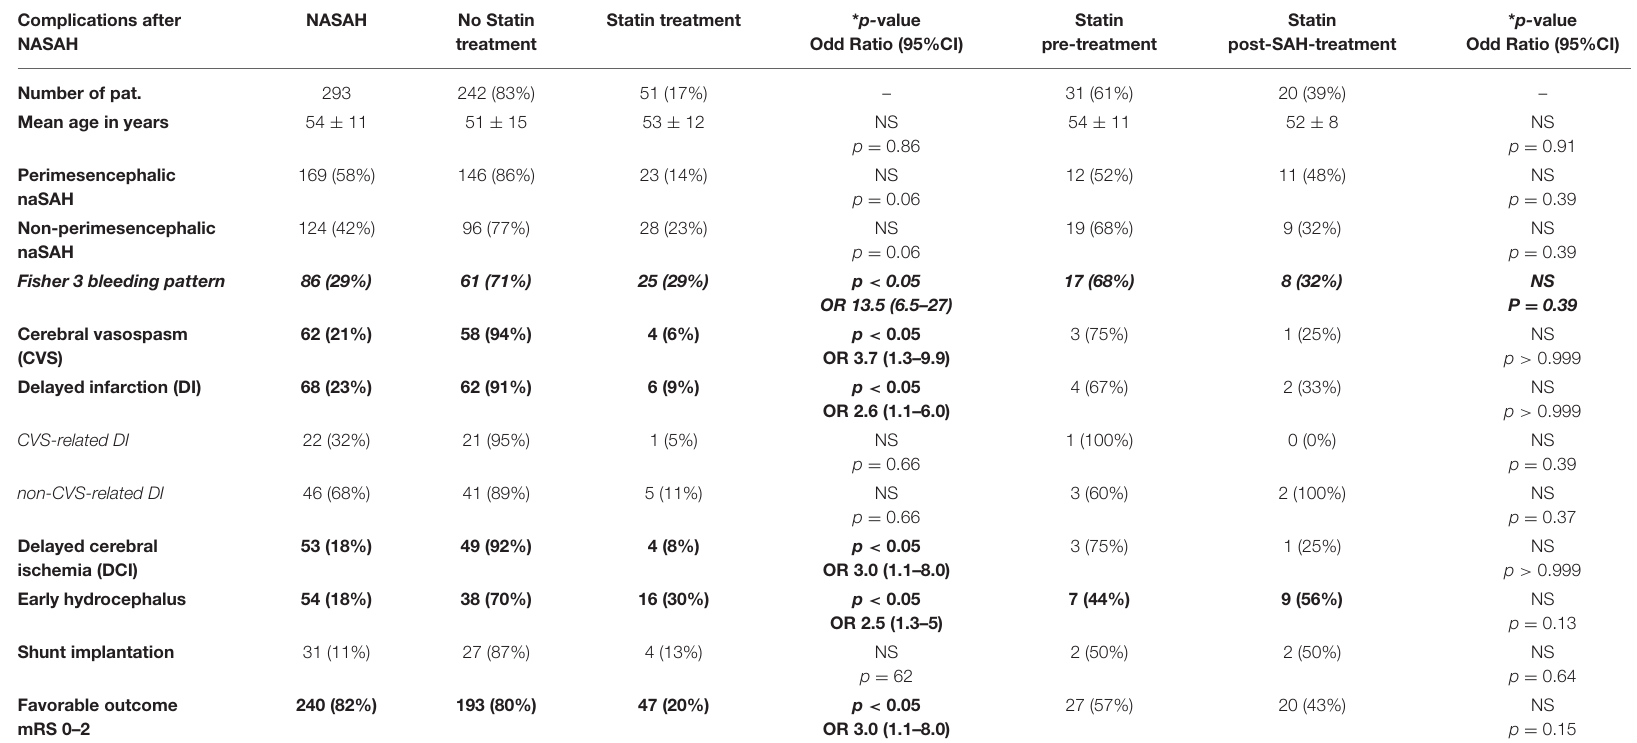
NASAH No Statin Statin treatment * p- value treatment